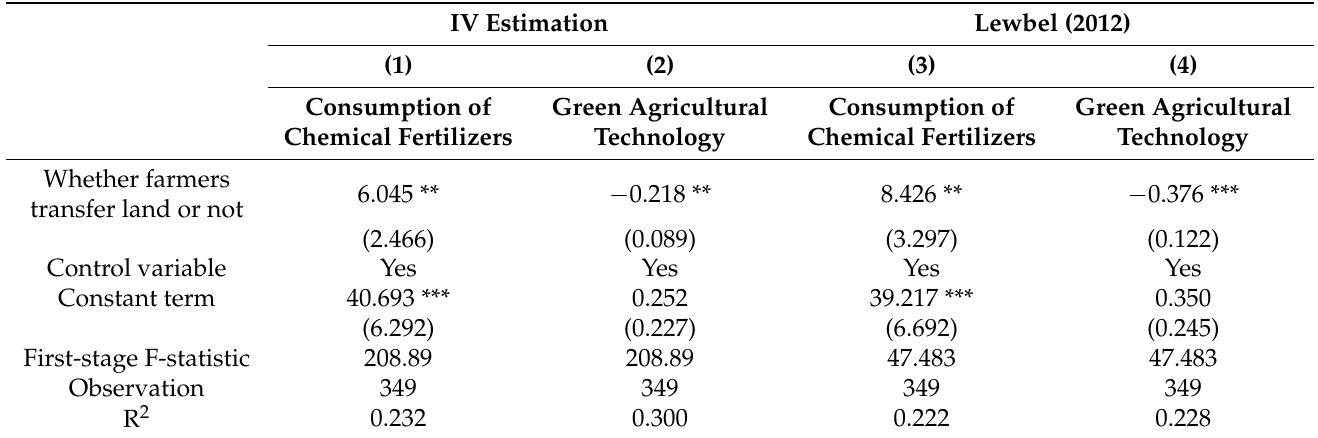
Table 3. Endogenous